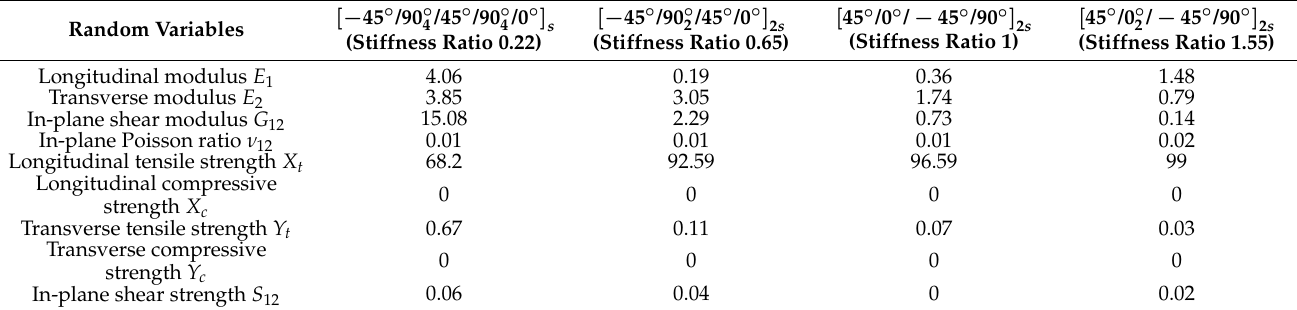
Table 5. Importance factors regarding material properties for notched laminate with 2 R = 3.81 mm (%).